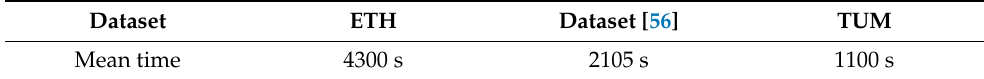
Figure 13. Experimental results of TUM scenes, the first row is the input scene model, the second row is the indoor scene components detection result: ( a ) Scene with a standing person; ( b ) Scene with two sitting person; ( c ) Scene with two standing person. Table 3. Mean executing times on dataset.